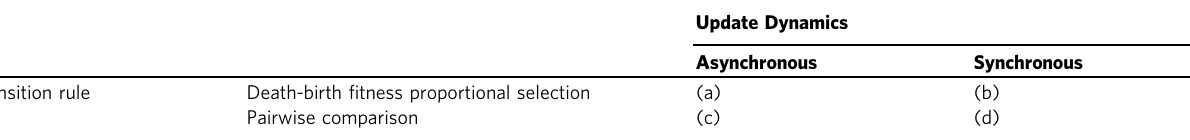
Table 1 Design of sensitivity analysis to study the effect of varying transition rules and update dynamics for the lattice model.